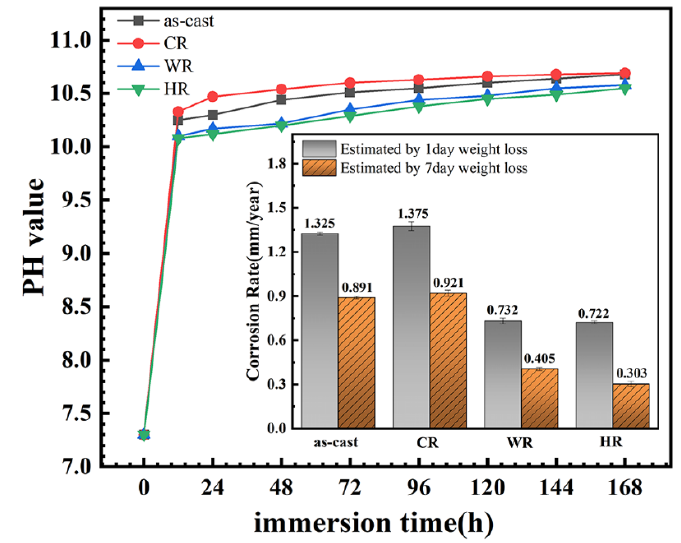
Figure 8. Variation in solution pH of the magnesium alloys with different states during 7 days of immersion in Hank’s solution and the corresponding corrosion rate obtained by weight loss.